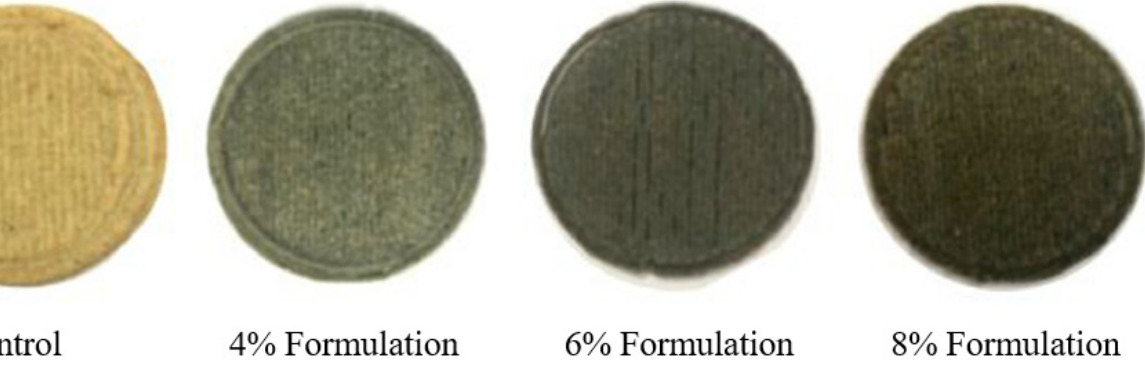
Figure 3. 3D-printed functional cookies with different levels of grape pomace powder